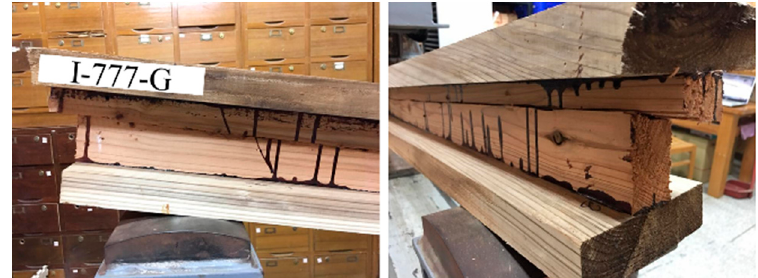
Figure 8. Horizontal shear failure at the web of the built-up I-beams.